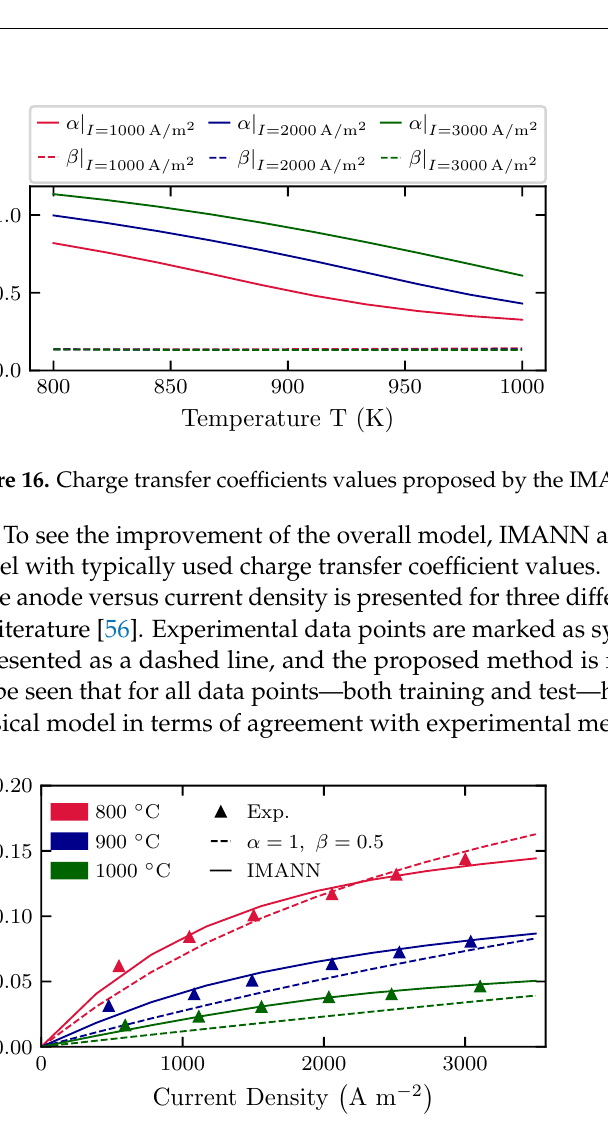
Figure 17. Overpotential curve comparison between IMANN grey-box model versus experimental data from [56] and numerical model with standard